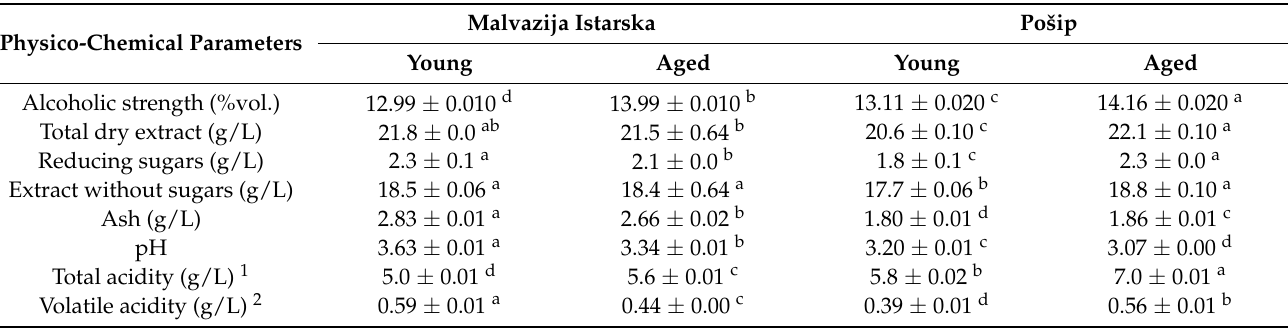
Table 1. Concentrations of standard physico-chemical analysis parameters of young and aged Malvazija istarska and Pošip wines.